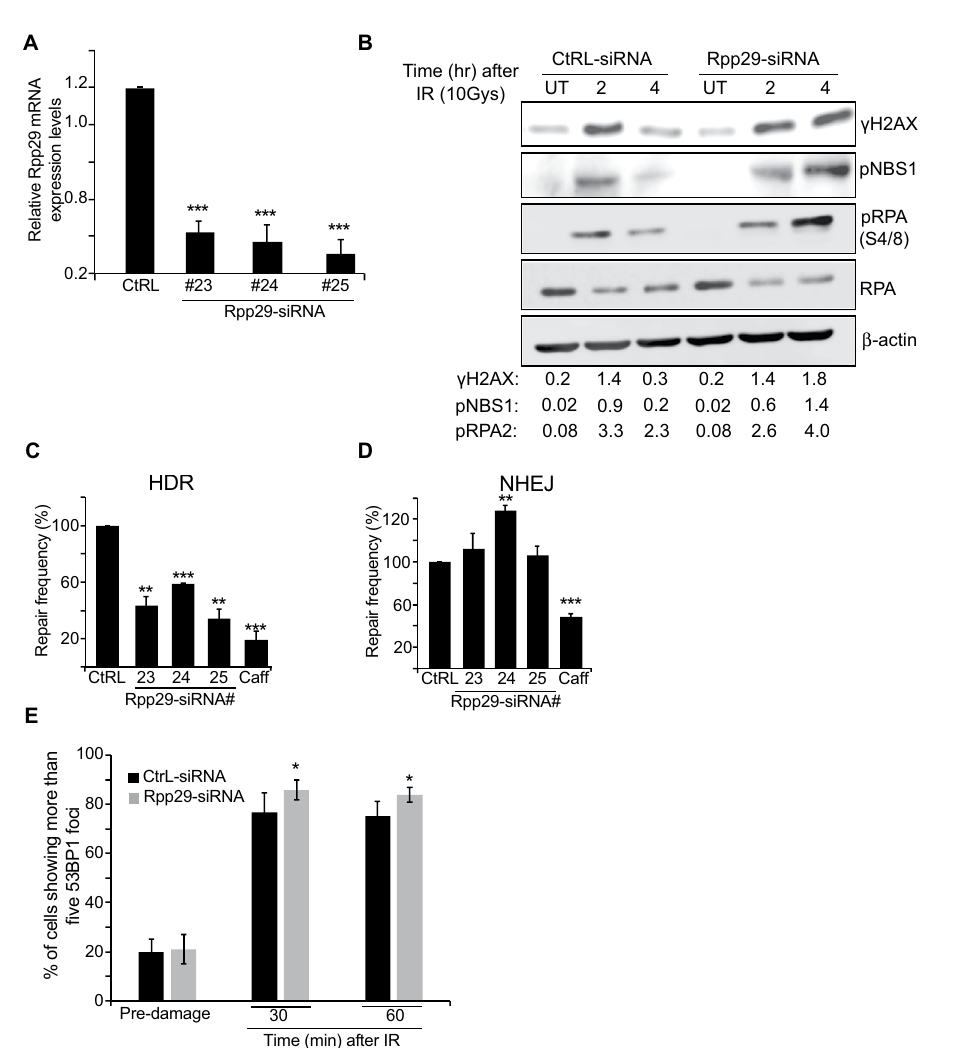
Interestingly, the above reduction of HDR was accompanied by an increase in mCherry production (Fig. 2D), an indication that Rpp29 depletion had no deleterious effect on the integrity of NHEJ. Apparently, the activation of NHEJ pathway is a counteracting response of the cells to elevated numbers of DSBs owing to the defective HDR. As a control, treatment of U2OS-TLR cells with caffeine, which is known to inhibit PIKKs 57 , brought to a